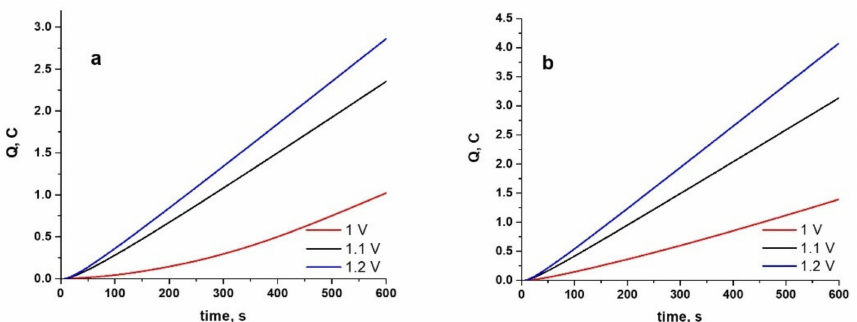
Figure 3. Charge–time plots during electrosynthesis of PPy at different constant potentials for 600 s on WBC ( a ) and Hera ( b ) CoCr alloys from ionic liquid electrolyte containing 0.5 M Py and 0.025 M